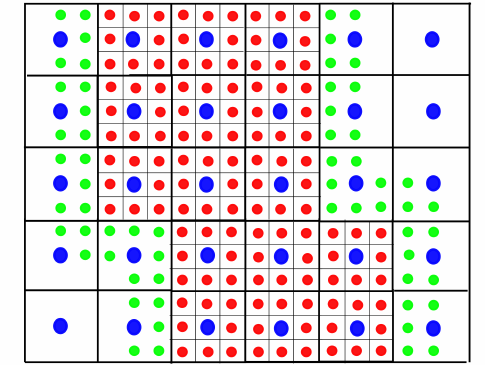
Figure 3. Two-dimensional AMR WENO